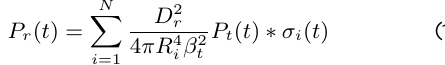
Figure 1: Cartesian voxel structure with projected differential backscatter cross